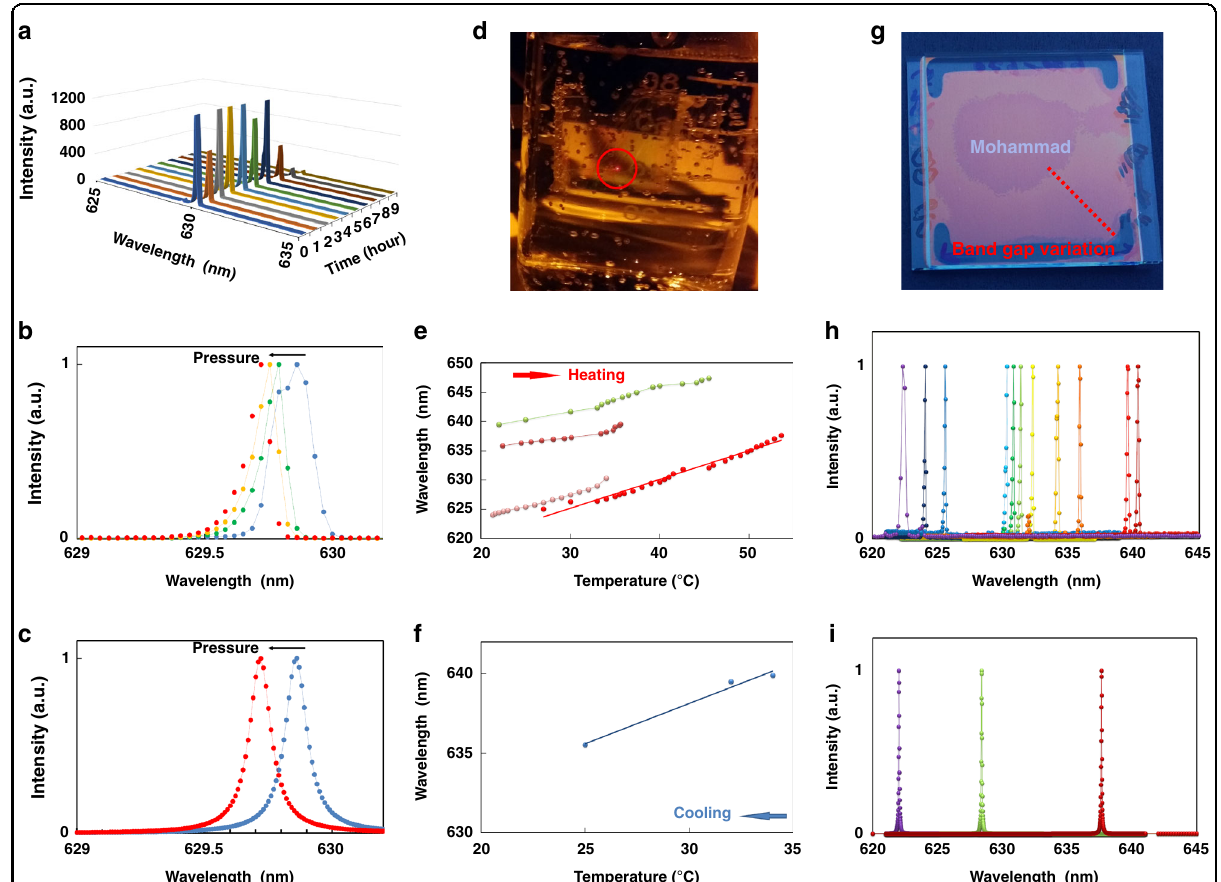
Fig. 3 Experiments evaluating external factors on the QDCLC fi lm. a Lasing spectra of a free-standing fi lm QDCLC laser for 9 h (32 million pulses) of continuous operation at 1 kHz. b Measured (four spectra, each time with a clamp added) and c simulated (for LC with reduced pitch) lasing spectra as a function of the pressure exerted on the QDCLC stack between two glass plates. d Photograph of the free standing QDCLC laser in hot water (54 °C). e Red shift (for four locations on the layer) and f blue shift of the lasing wavelength by heating and cooling of the water. g Photograph of a CLC mirror between two glass plates with two domains, in which the variation in the thickness and in the re fl ection band is observed along the red dashed line. h Measured (for 11 different locations) and i simulated (for three different CLC pitches) lasing spectra for a free-standing fi lm with variable CLC